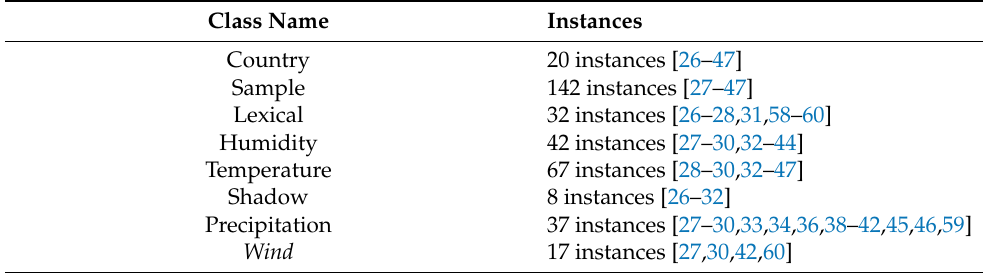
Table 6. Instances and class attributes for the Country, Sample, Lexical, Humidity, Temperature, Shadow, Precipitation, and Wind variables.